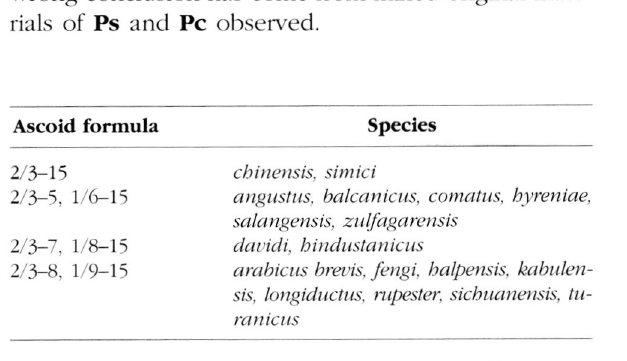
Table V. - Ascoid formula of male subgenus Adlerius phlebotomine